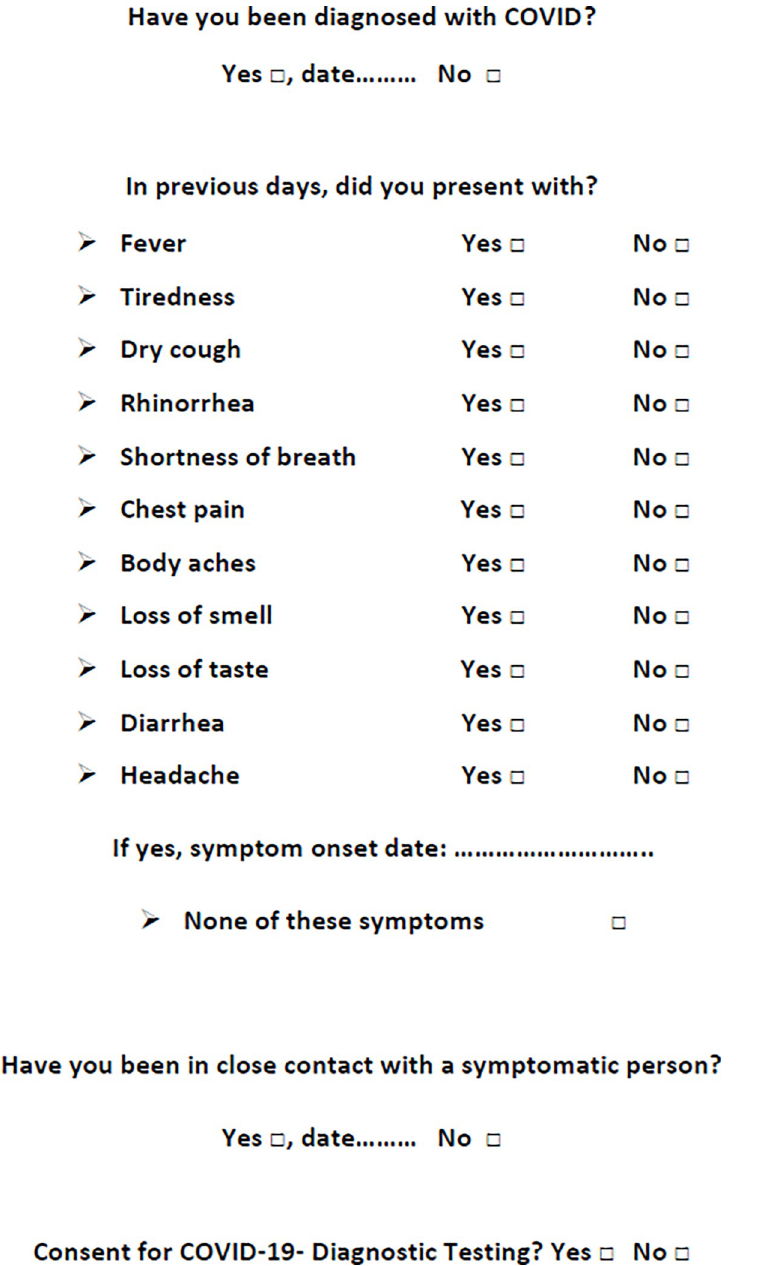
Fig 1. Preoperative COVID-19 symptom-based screening